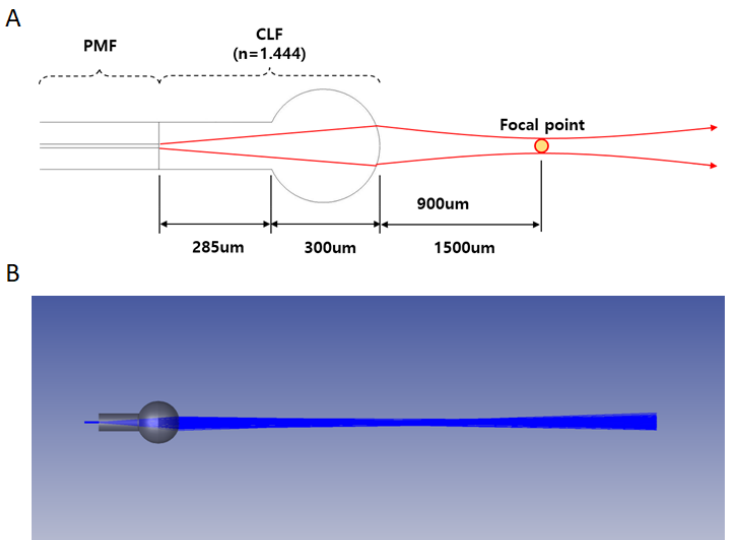
Figure 3. Schematic representation of the ball-lensed optical fiber (BLOF). ( A ) Structure of the B ) Simulated results of the BLOF using Zemax BLOF. ( B ) Simulated results of the BLOF using Zemax software. (